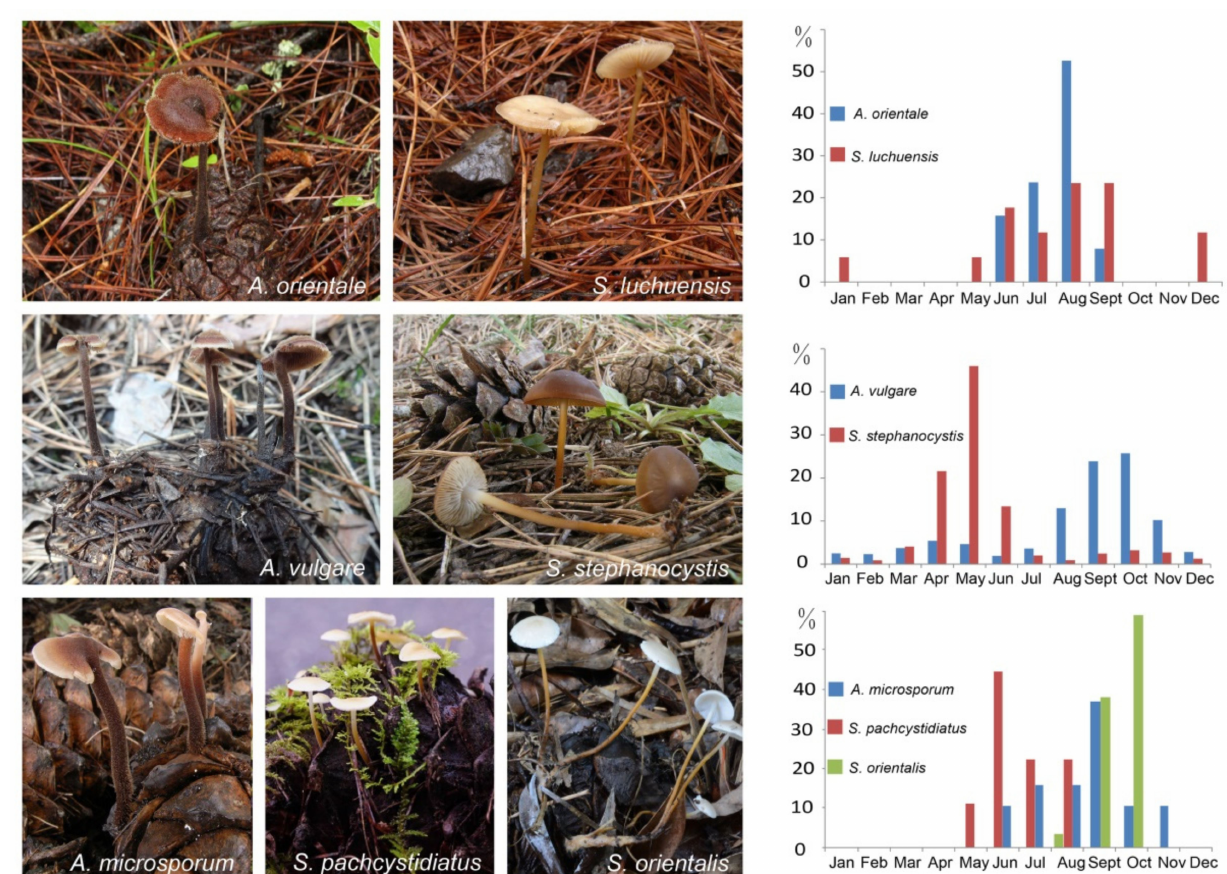
Figure 1. Basidiomata and percentage of monthly occurrences of fruiting bodies of Auriscalpium and Strobilurus on pinecones. The basidiomata of Auriscalpium usually on newly fallen cones on the ground. The basidiomata of Strobilurus usually on highly rotten cones under the ground. For the graphs, the x -axis shows months and the y -axis shows percentage of monthly occurrences of collected or observed fruiting bodies on pinecones in different areas and years in Table S1.